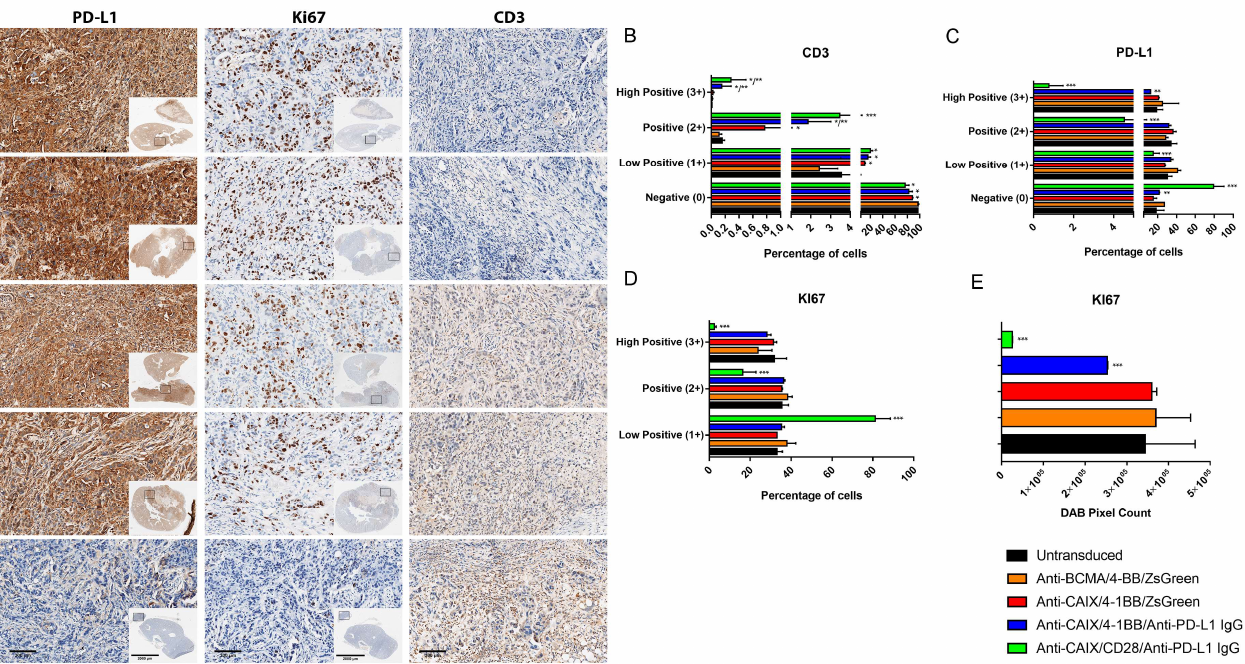
Figure 4. Immunohistochemical analysis of human clear cell renal cell carcinoma (ccRCC) from an orthotopic NSG mice model to evaluate in vivo activity of Anti-carbonic anhydrase IX (CAIX) CAR T cells. ( A ) Immunohistochemistry analysis of tumor sections by detecting PD-L1, KI67, and CD3 expression. The scale bars represent the magnification of the images of each column [2000 μm (4×) or 300 μm (20×)]. ( B – E ) Immunohistochemistry (IHC) Quantification. The images quantification was performed using the IHC Profiler Plugin of ImageJ Software [22]. The percentages of negative (0), low positive (1+), positive (2+), or high positive (3+) cells were shown. For CD3 ( B ) and programmed cell death ligand-1 (PD-L1) ( C ) quantification, cytoplasmatic quantification was applied where all of the image diaminobenzidine (DAB) pixels were counted. For the quantification of nuclear protein KI67 ( D ), the DAB staining pattern is confined to the nuclei, the threshold feature is used to select the positive-stained areas for quantification, and non-staining nuclei are not recorded [22]. DAB total pixels were also shown ( E ) to evaluate total Ki67 staining in all fields, including negative areas. * p < 0.05 compared with untransduced and anti-B cell maturation antigen (BCMA)/4-1BB/ZsGreen, ** p < 0.05 compared with anti-CAIX/4-1BB/ZsGreen, *** p < 0.05 compared with anti-CAIX/anti-PD- L1 IgG4 compared with all other groups. To assess the potential liver toxicity induced by the on-target off-tumor effect of anti- CAIX CAR T cells in the biliary duct, we analyzed the infiltration of CD3 cells in the liver by immunohistochemistry (Figure 5A,B); however, no statistical differences in the infil- tration of anti-CAIX CAR T cells in the hepatic parenchyma among the groups were found after image quantification. (Figure 5B). We also measured alanine transaminase (ALT), aspartate transaminase (AST) (Figure 5C), and creatinine (Figure 5D) levels in the plasma of mice to assess liver and kidney function [23]. No significant difference in the expression of these markers was found among the groups, providing further evidence for the absence of hepatic and nephrotoxicity with doses equivalent to 10 7 anti-CAR T cells/kg.